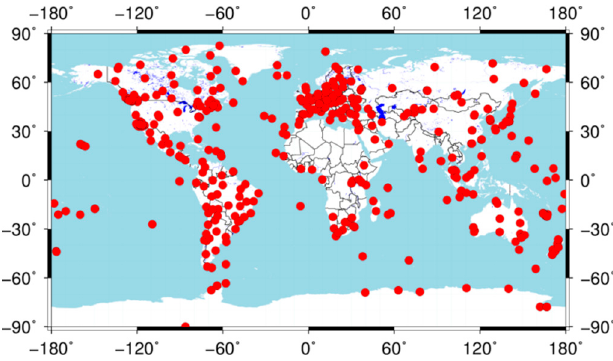
Figure 2. Geographical distribution of the 492 IGS stations.